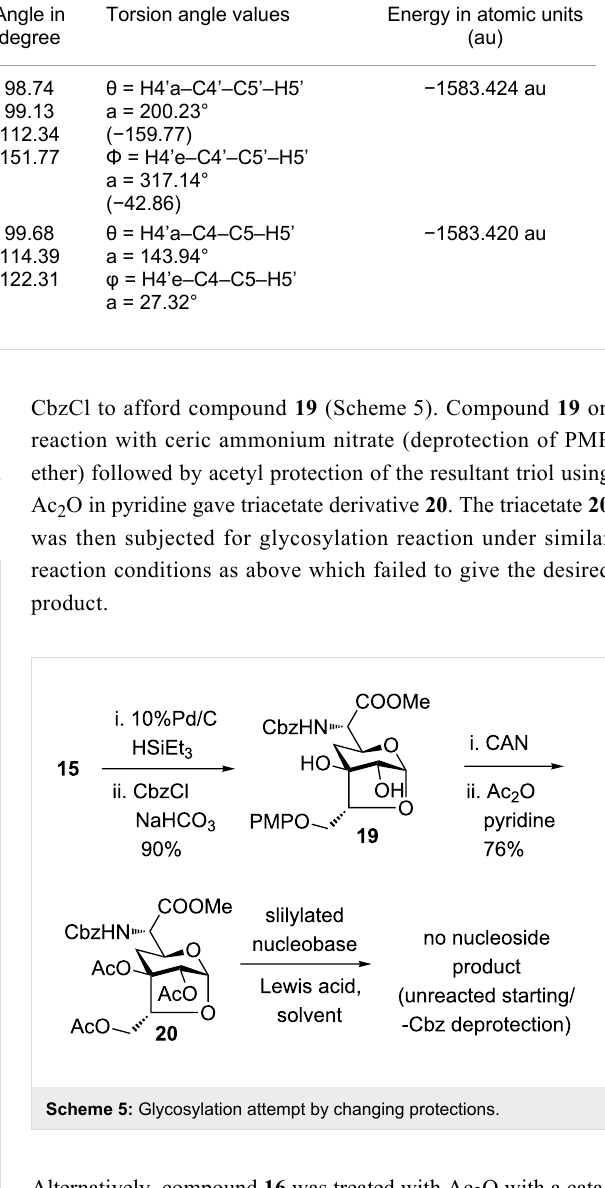
Table 1: Geometrical parameters for hydrogen bonding and torsion angles for 12 and 13 .